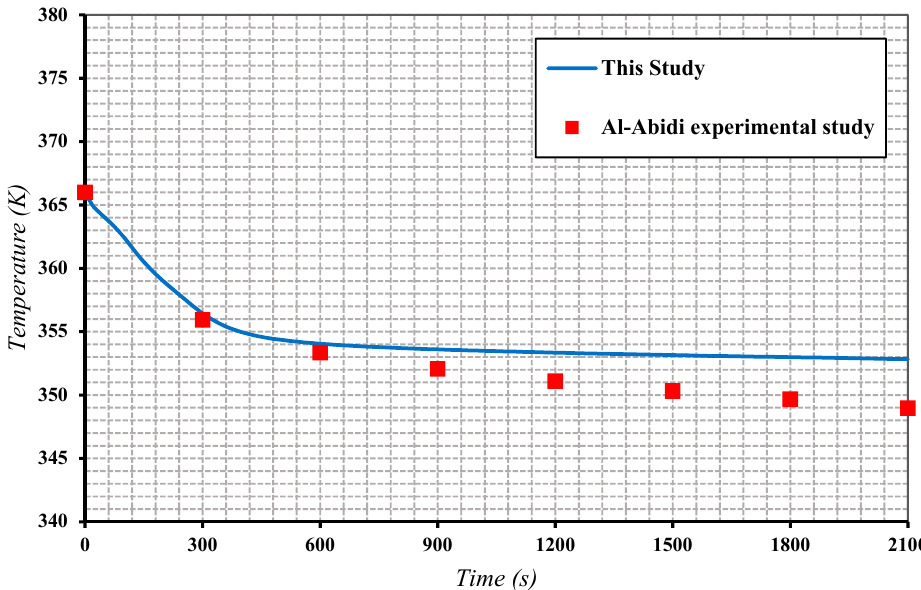
Figure 3. Comparison of the temperatures obtained from the CFD simulation (this study) with the experimentally values reported by Al-Abidi et al. [33].